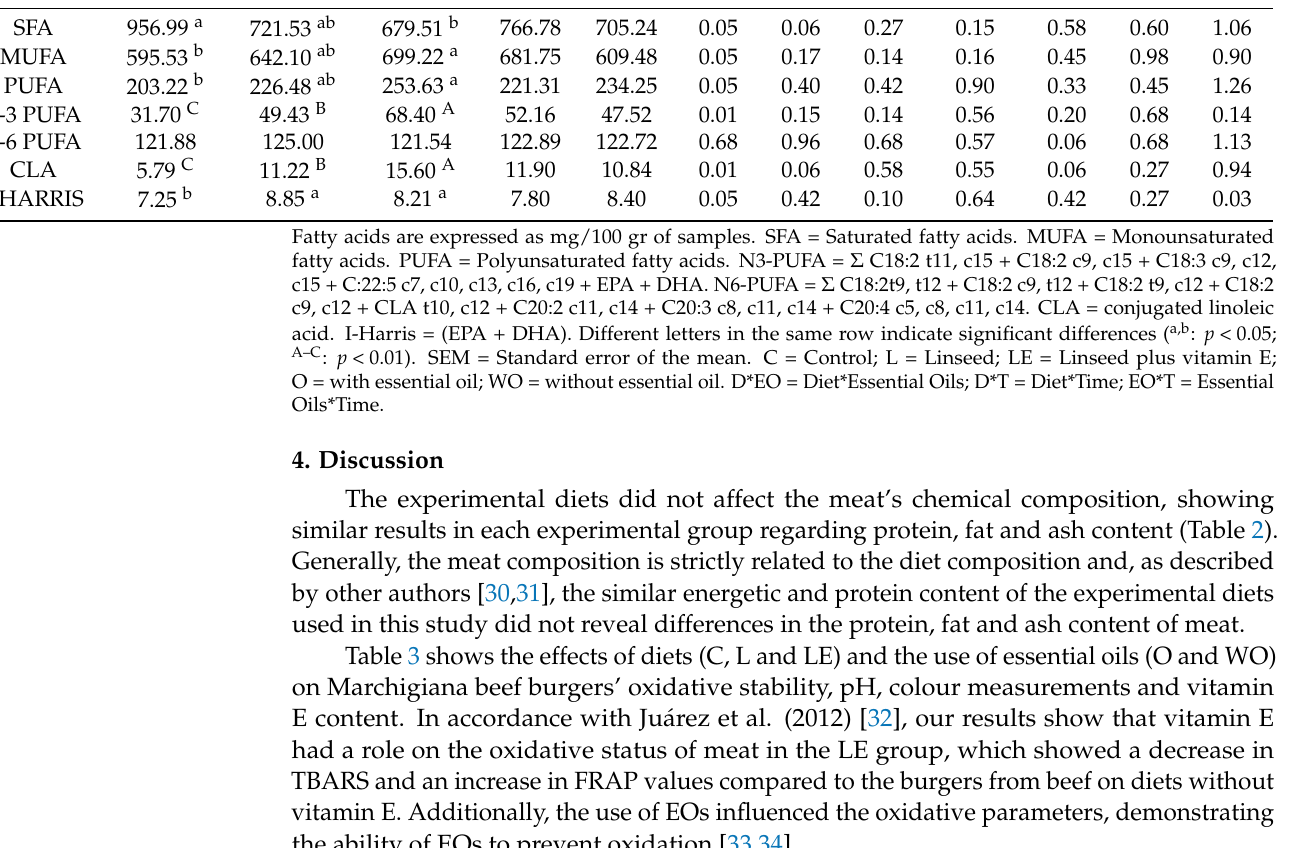
Table 4. Effects of experimental diets (C, L and LE) and treatment (EO) with (O) and without essential oils (WO) on health indices and pro-oxidant fatty acids on Marchigiana beef meat on days 0 and 12 of storage. EO p